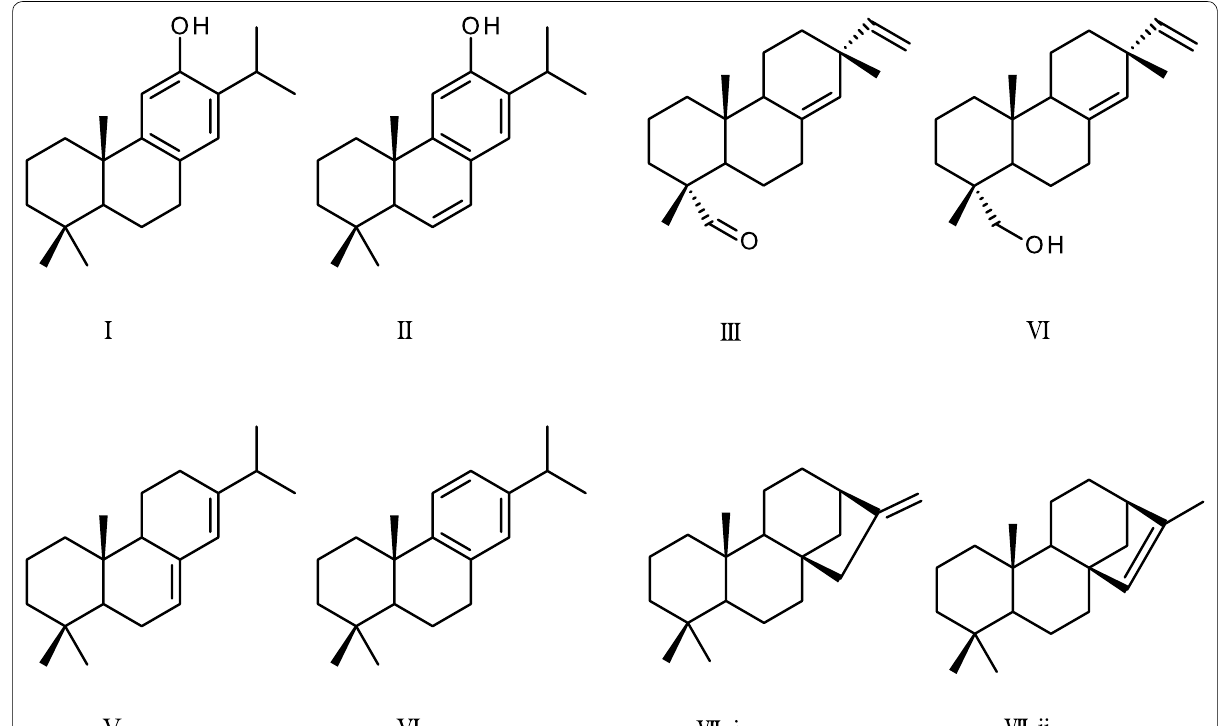
Fig. 1 Chemical structures of diterpenes from sugi wood. Ferruginol (I), 6,7-dehydroferruginol (II), sandaracopimarinal (III), sandaracopimarinol (IV), abietadiene (V), abietatriene (VI), phyllocladene (VII-i), isophyllocladene